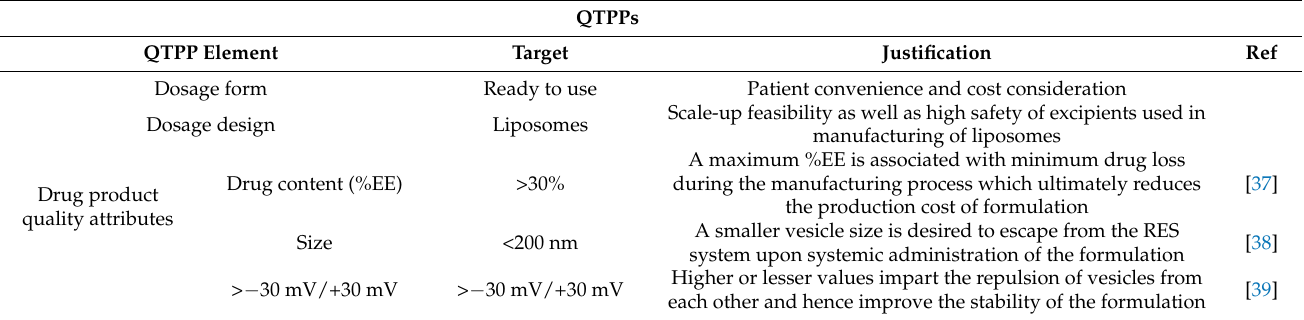
Table 1. QTPPs and CQAs for